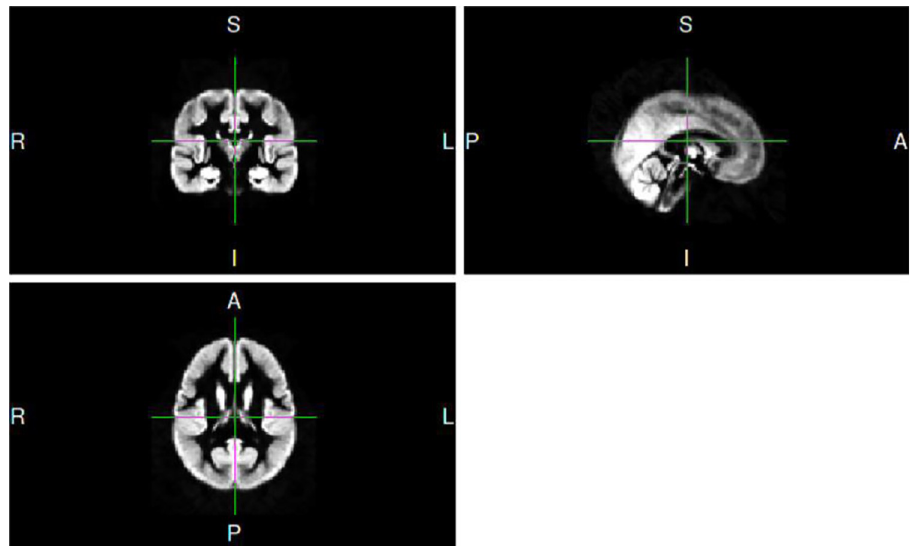
Fig 1. The final gray matter